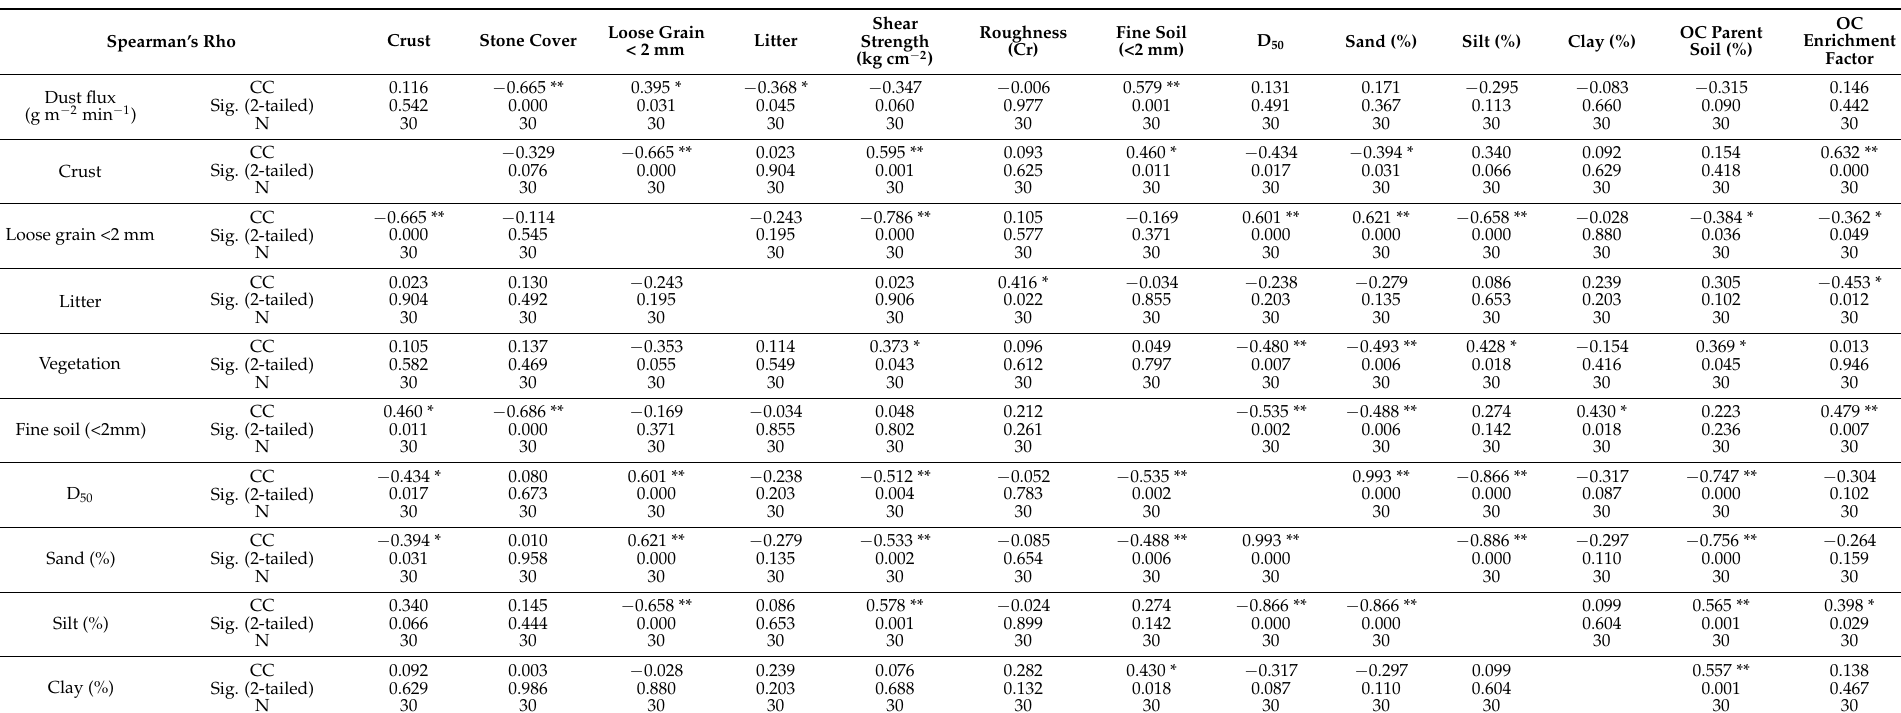
Table 7. Correlation analysis (selected